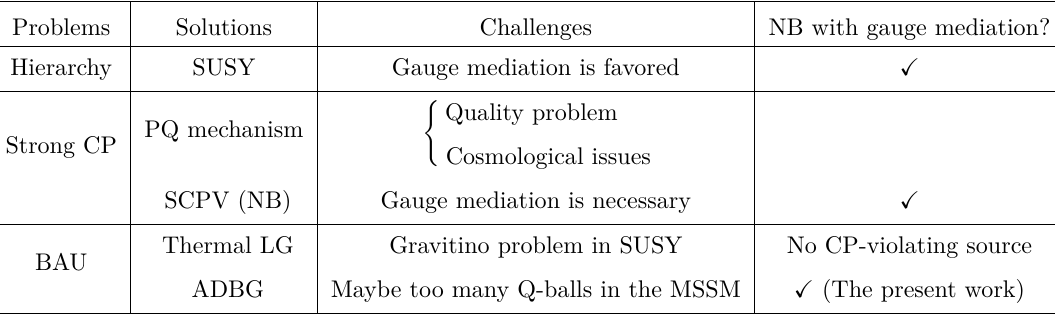
Table 1 . Summary of possible solutions for the problems in the SM and their challenges in 3+1 dimensions (NB = the NB model; SCPV = spontaneous CP violation; BAU = baryon